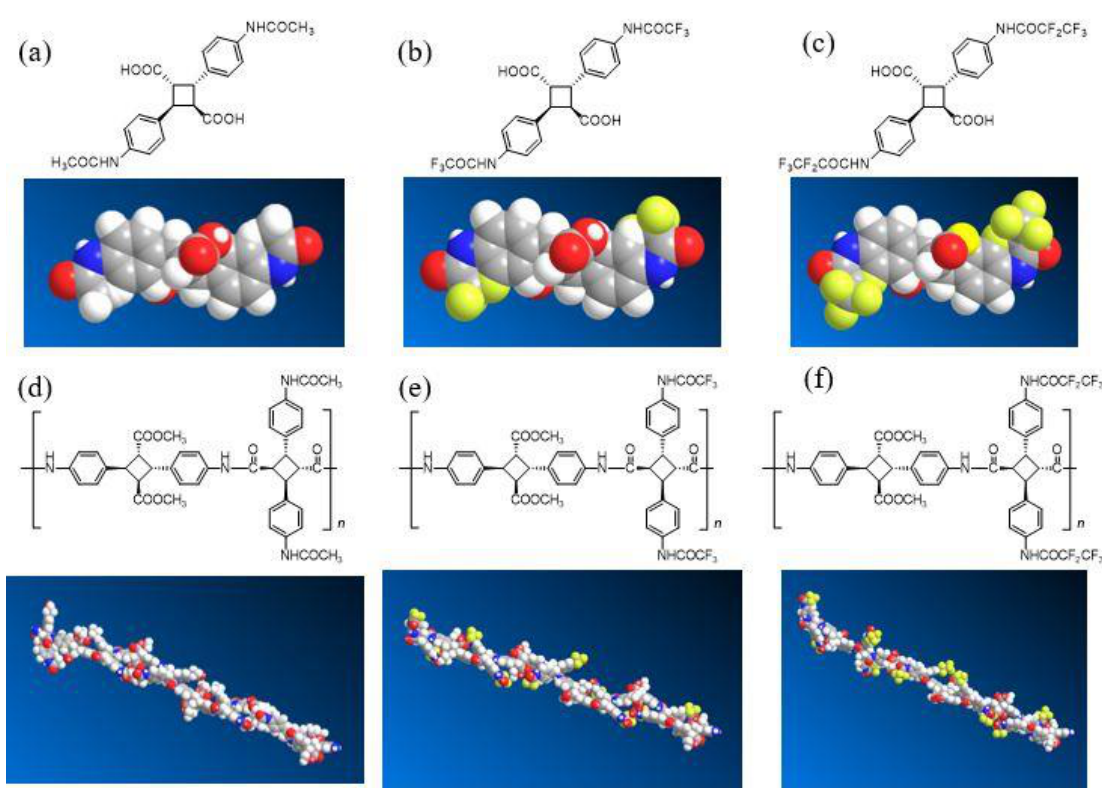
Figure 2. Molecular structure of non-fluorinated and fluorinated dicarboxylic acid ( a , b , c ) and its polyamides ( d , e , f ).